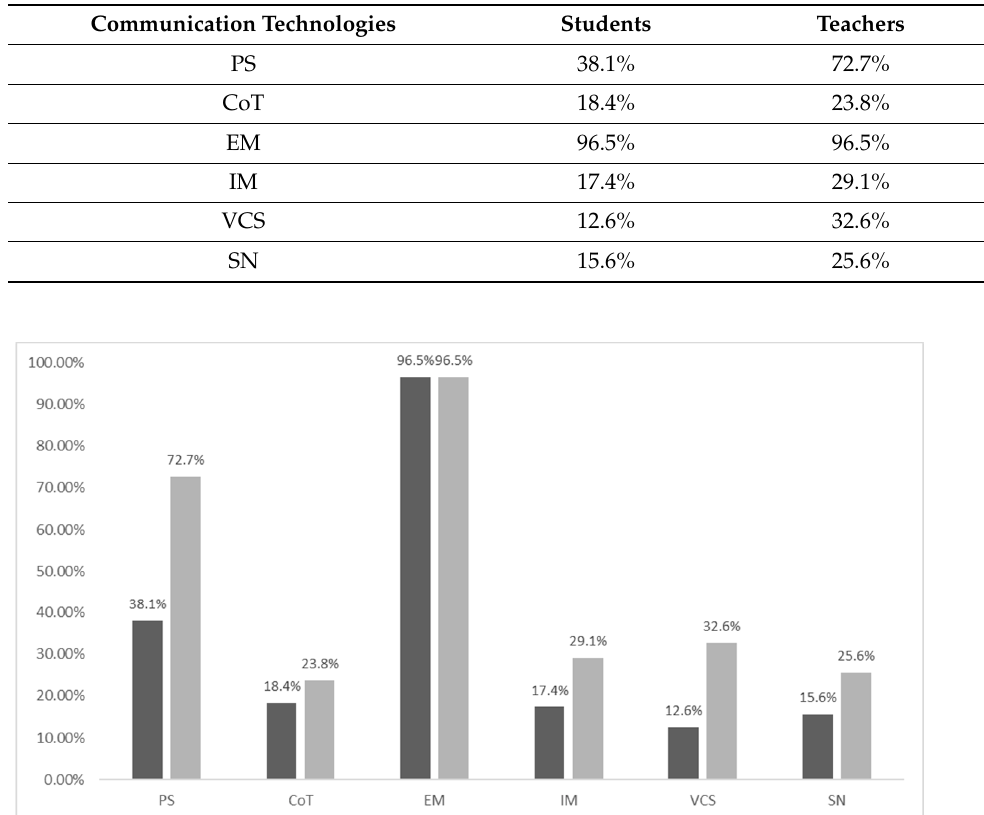
Table 7. Usefulness of the use of communication technologies by students.